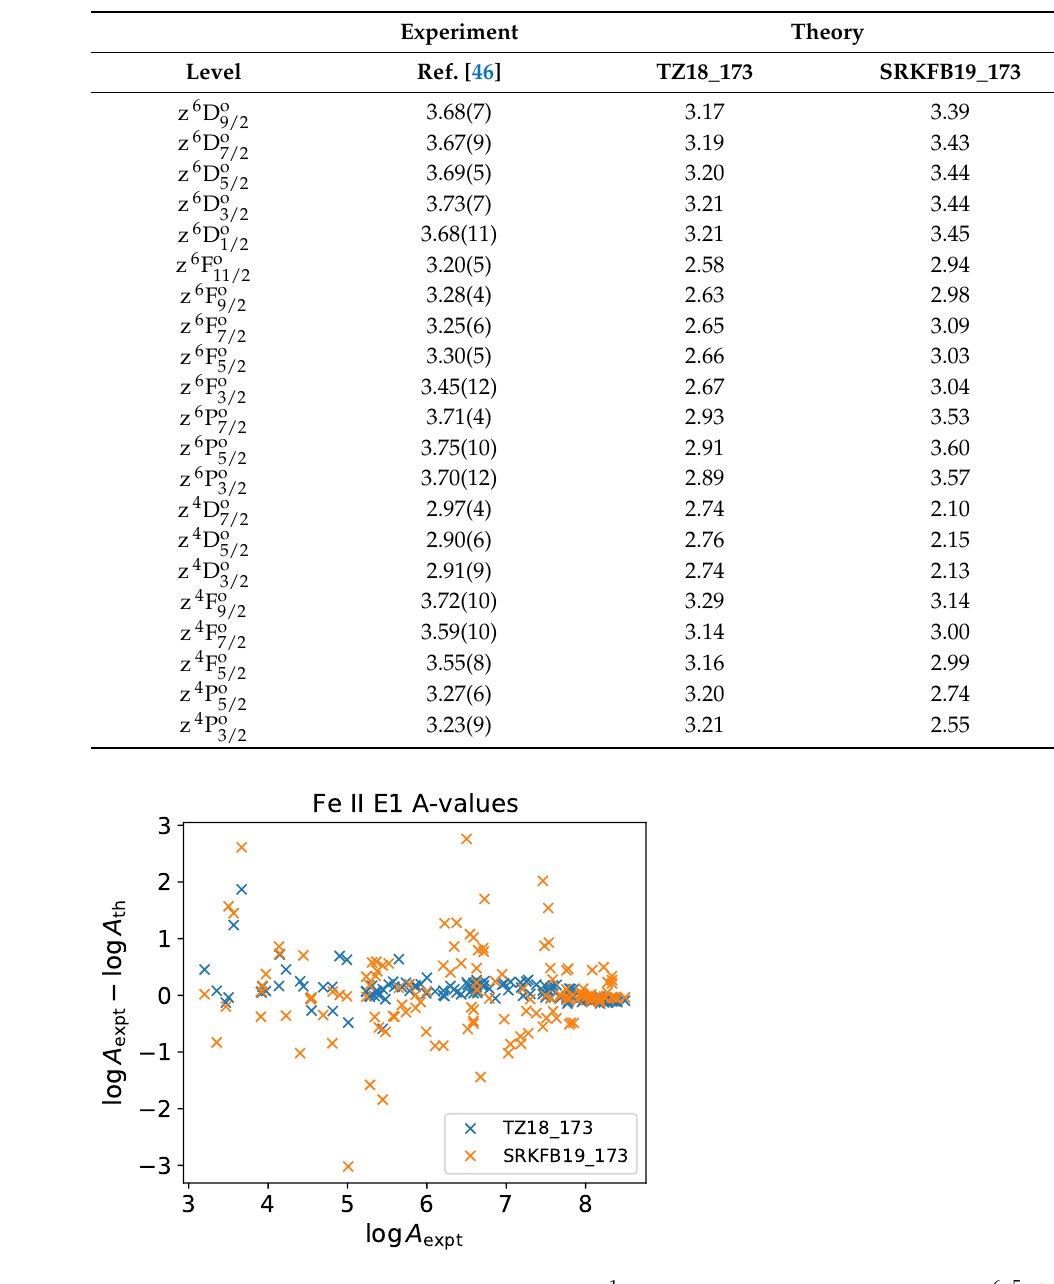
Figure 12. Comparison of experimental A -values (s − 1 ) for E1 transitions arising from the 3d 6 ( 5 D ) 4p levels of Fe II [46] with those from the atom datasets TZ18_173 and